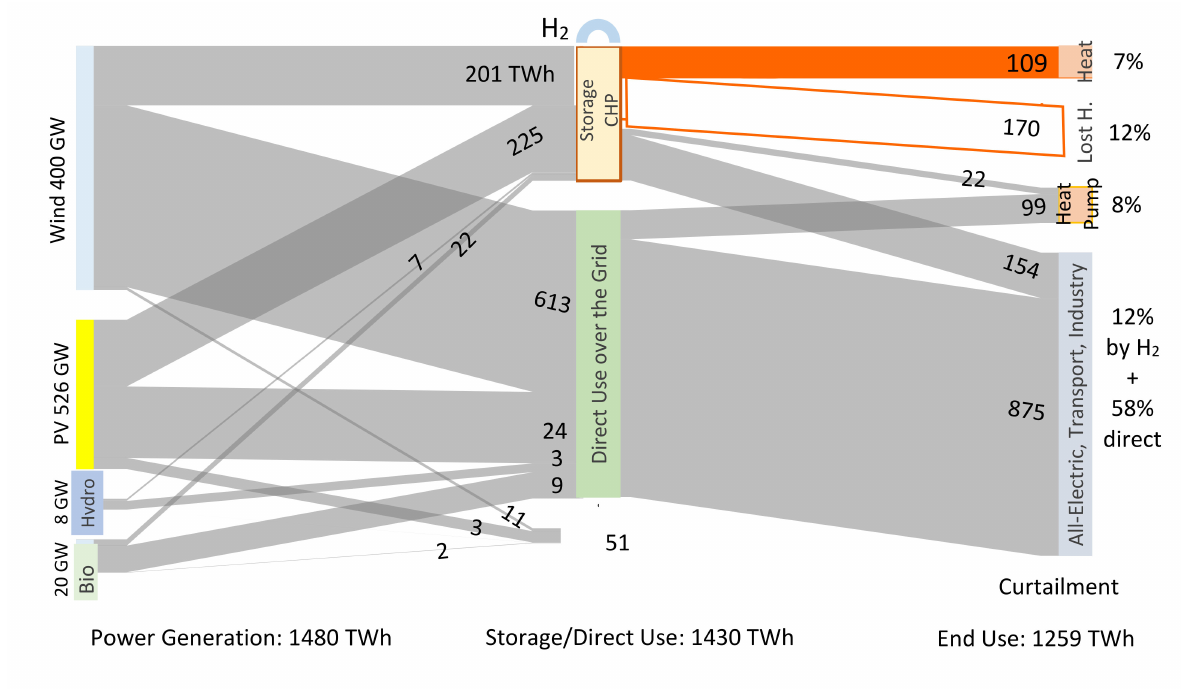
Figure 4. Energy flows for an all-electric renewable Germany as a snapshot of 2030. Decentral Storage CHP compensates for 100% of the power fluctuations and provides heat (red) for 23% of the buildings, while 77% are heated by heat pumps. Remark: The heat pumps achieve a much higher heat coverage, since their input power is multiplied by their coefficient of performance COP =